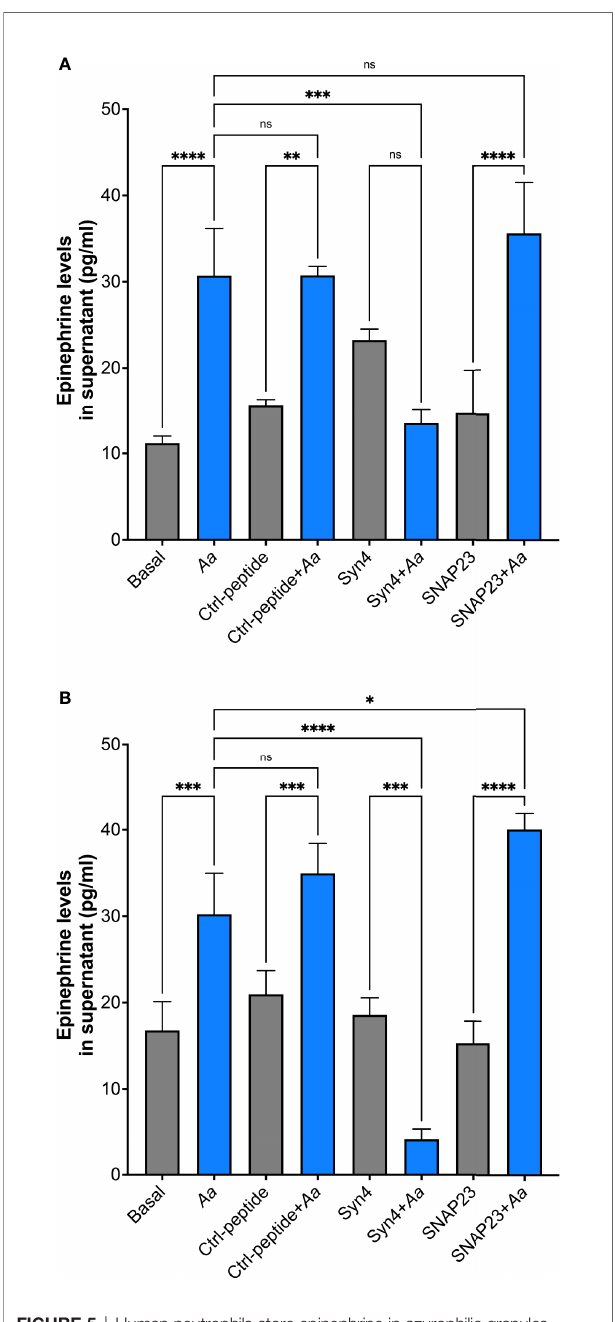
FIGURE 5 | Human neutrophils store epinephrine in azurophilic granules. Epinephrine storage location was determined by pre-treating human neutrophils with TAT-Syntaxin 4 (Syn4), TAT-SNAP23 (SNAP23), or TAT-Ctrl (Ctrl) for 15 min, followed by a 4-h challenge with A . actinomycetemcomitans at MOI 50 (A) or 8 h (B) . Epinephrine concentrations are plotted as the mean ± SD of three independent experiments. Statistical differences among experimental conditions were analyzed by ordinary one-way ANOVA, followed by Tukey ’ s post-test. ns, not signi fi cant, * p < 0.05, ** p < 0.01, *** p < 0.001, **** p <